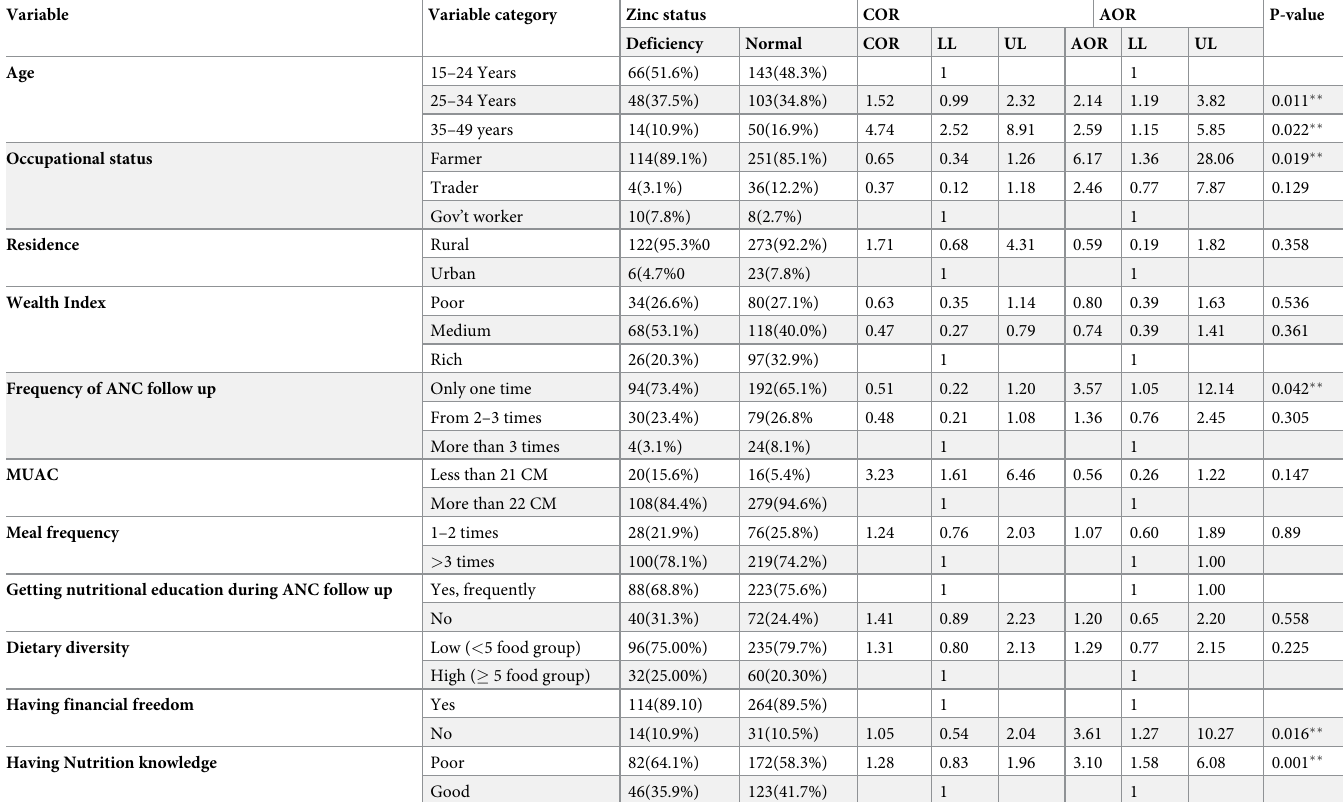
Table 3. Zinc deficiency and associated factors among pregnant women attending antenatal clinics of Konso Zone public health facilities, Southern Ethiopia,